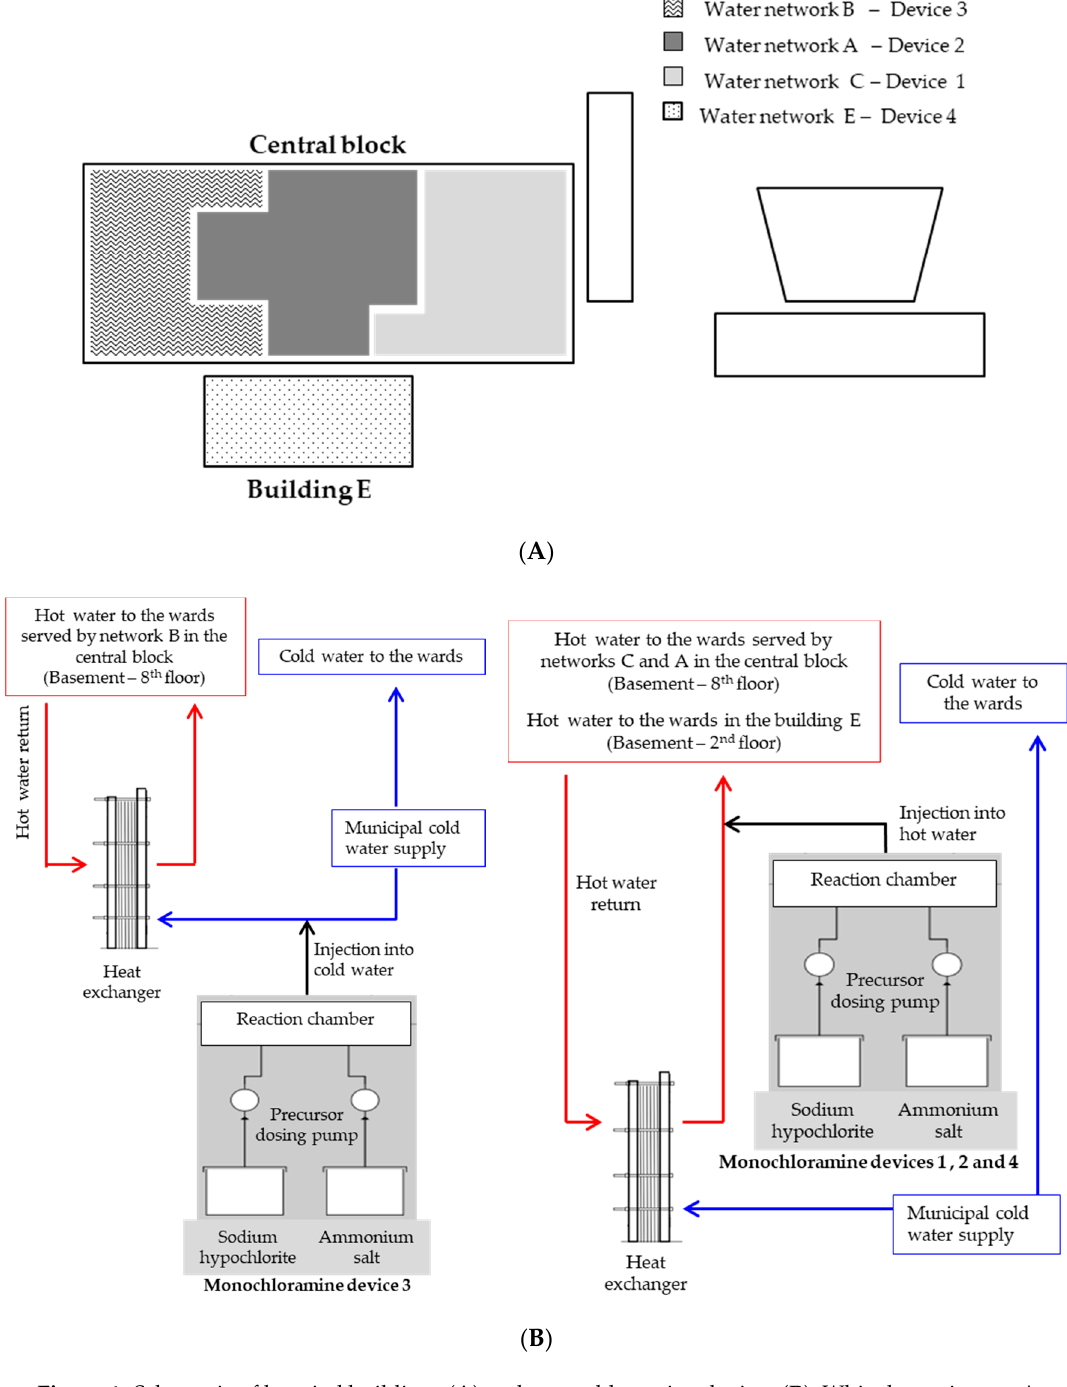
Figure 1. Schematic of hospital buildings ( A ) and monochloramine devices ( B ). White boxes in part A represent hospital buildings without monochloramine devices.